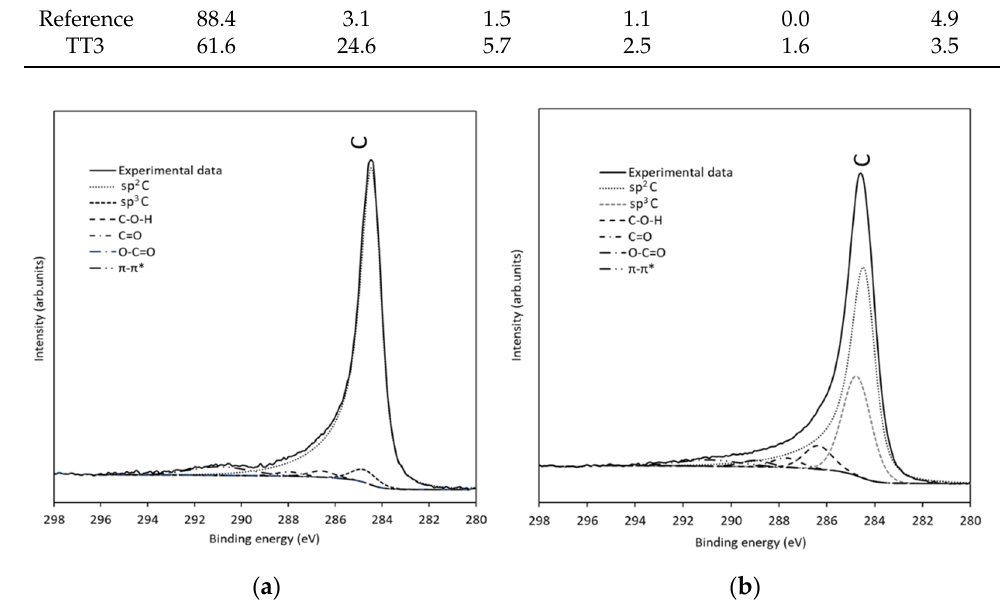
Figure 7. XPS Spectra and fitting for ( a ) reference GF and ( b ) TT3 thermally treated GF.